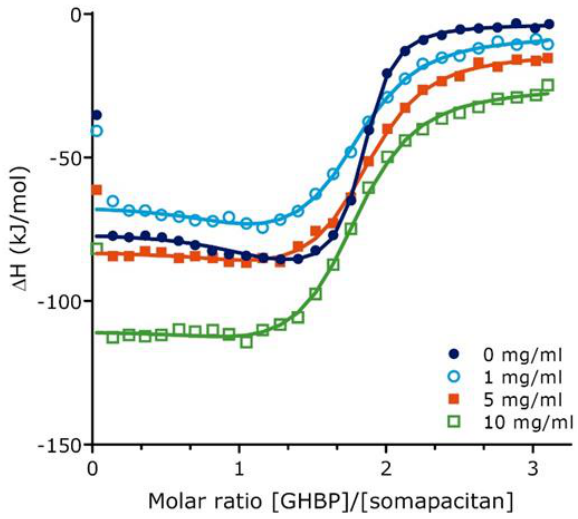
Figure 2. Growth hormone binding protein binding to somapacitan and effect of human serum albumin as measured by isothermal titration calorimetry. Integrated binding isotherms for GHBP (155 µM) binding to Somapacitan (10.2 µM) in absence of HSA (0 mg/mL HSA) (depicted in dark blue) and in presence of increasing concentrations HSA (1mg/mL in light blue, open circle; 5 mg/mL orange, square; 10 mg/mL green; open square). Data treatment was done using a two sets of site fitting model with a fitted offset compensating for the heat of dilution. Binding parameters are reported as the average of individual runs.